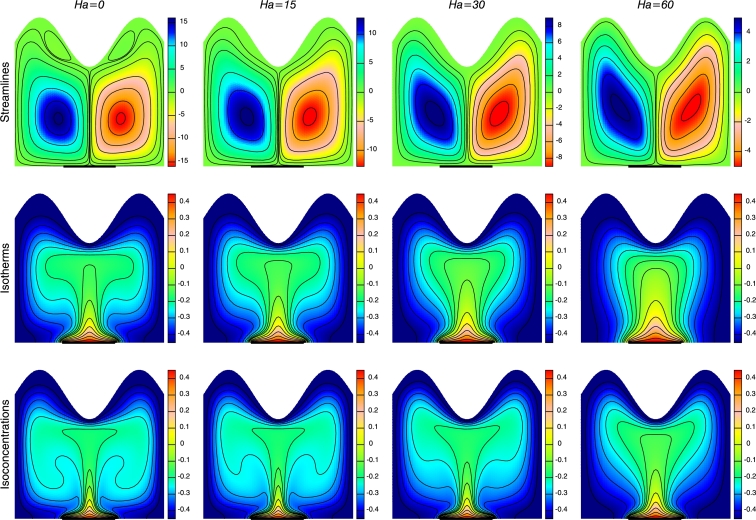
Streamlines, Isotherms and Isoconcentrations for different Ha at Ra = 105, N = −2, n = 3 and ϕ = 0.1.